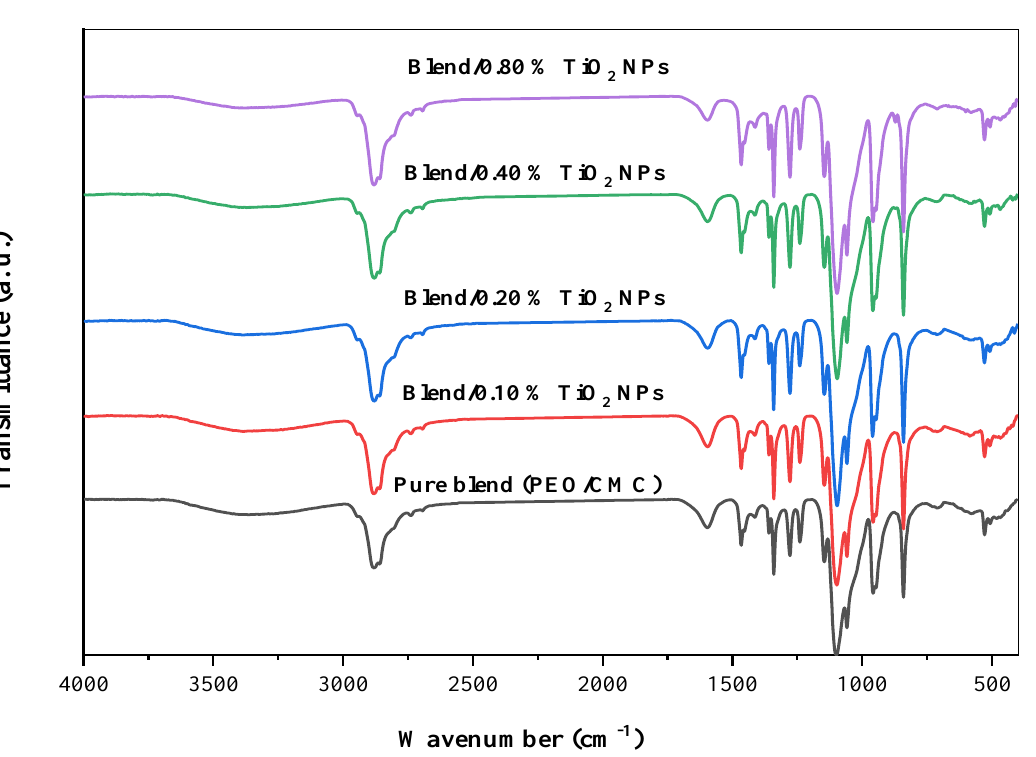
Figure 3. FT-IR transmittance spectra of PEO/CMC/TiO 2 NP nanocomposite samples